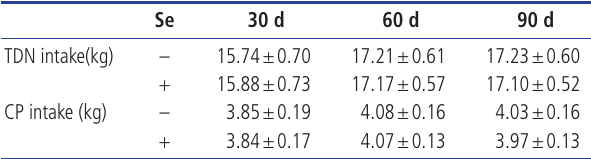
Table 2. TDN intake (kg) and CP intake (kg) at 30, 60, and 90 days after calving